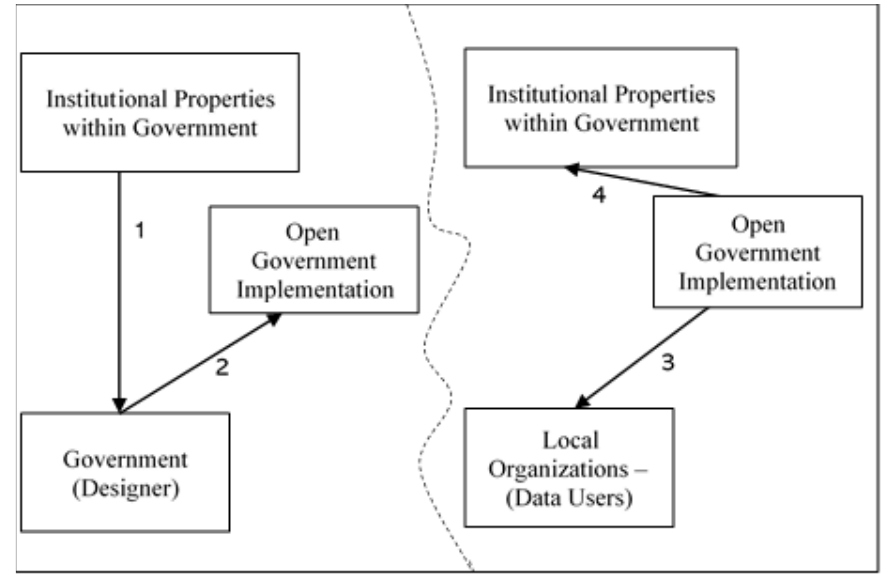
Figure 2: Designer and User Discontinuity of Open Government in the Philippines (Adapted from Orlikowski’s Time-Space Discontinuity in Traditional Models of Technology Design and Use,